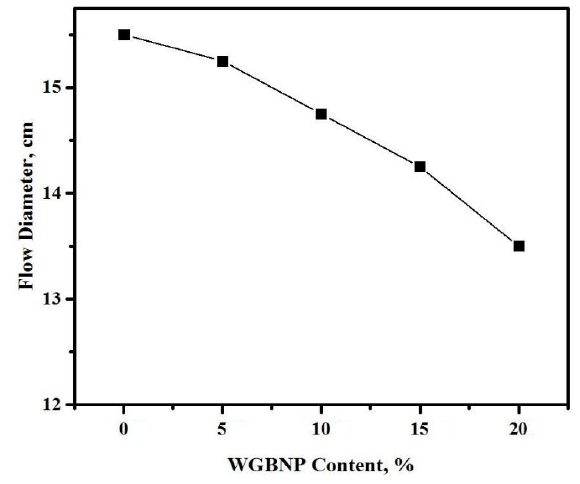
Figure 4. BGWNP content dependent flow diameter variation in prepared AAMs.